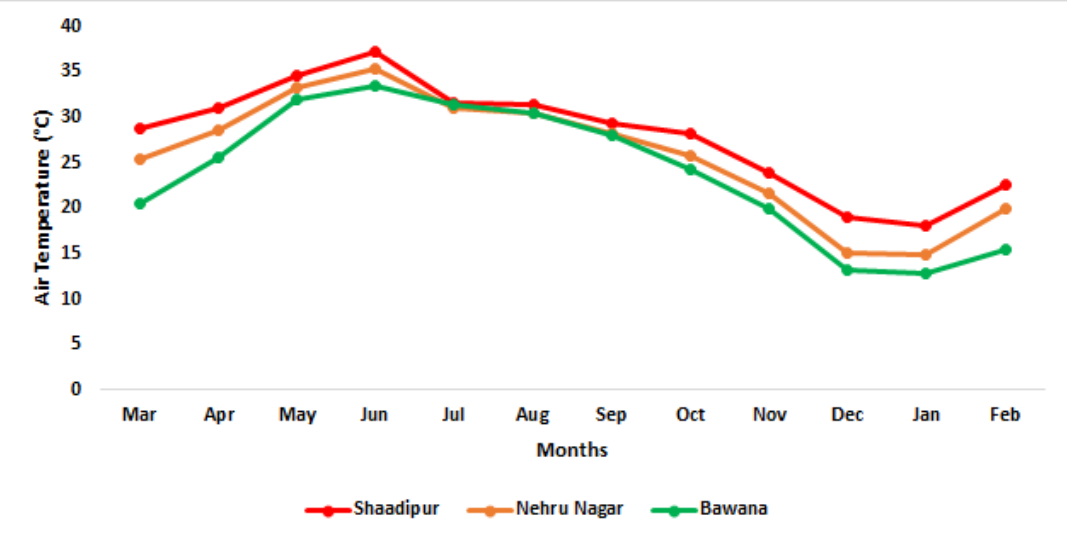
Figure 6. Monthly average air temperature pattern over three sites of Delhi.